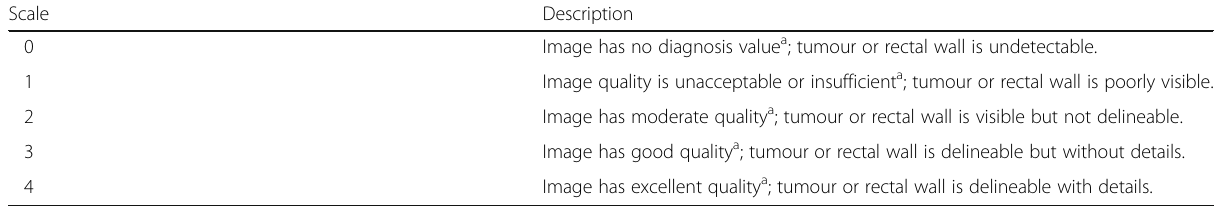
Table 2 Description for DWI image quality scales